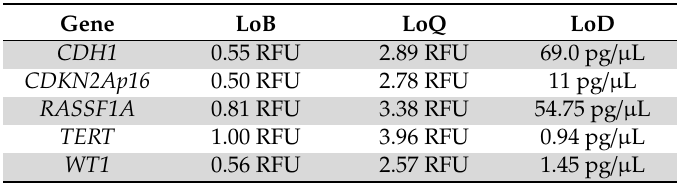
Table 5. Assay validation parameters Limit of Blank (LoB), Limit of Quantification (LoQ), and Limit of Detection